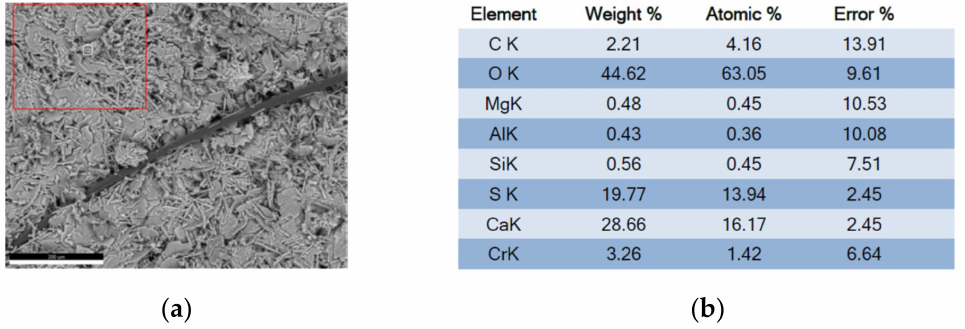
Figure 15. Analysis area and composition results ( a ) micrograph of the analysis area; ( b ) composition results of annexed area. (Source: the